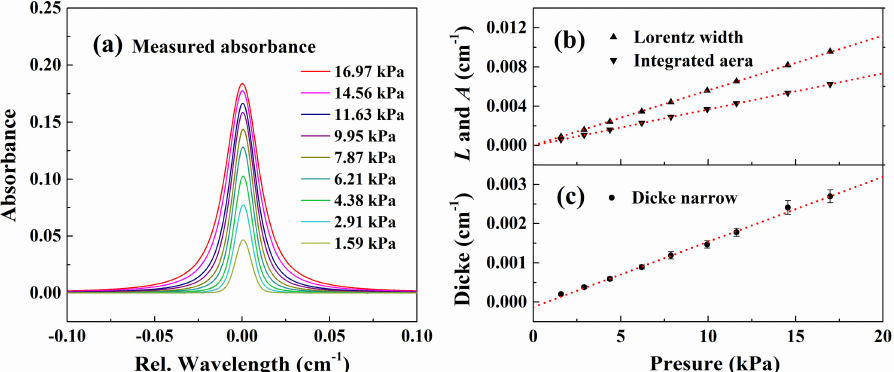
Figure 9. ( a ) Measured absorbance under di ff erent pressures. ( b ) Best-fit Lorentz widths and integrated areas versus pressure. ( c ) Best-fit Dicke narrowing coe ffi cient and its two-parameter linear fit. The experimental conditions are: CO / N 2 mixture gas, T = 299 K, L = 14.7 cm, Xco = 3.80%.